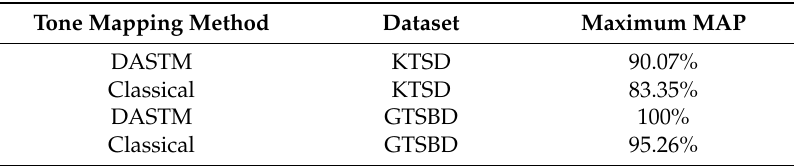
Table 1. Comparison of DASTM with classical tone mapping.